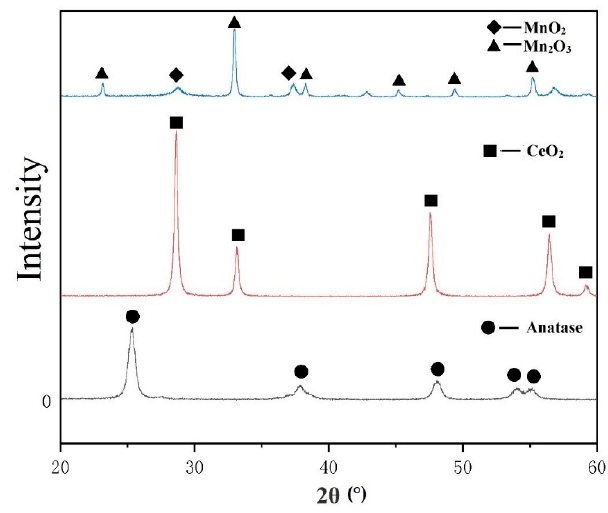
Figure 4. XRD of the initial powder.